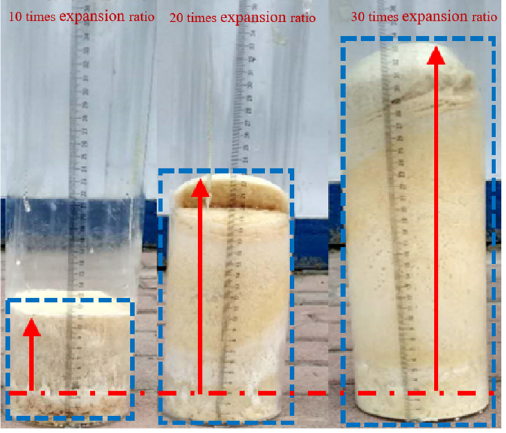
Figure 1. Polymer consolidation after reaction.